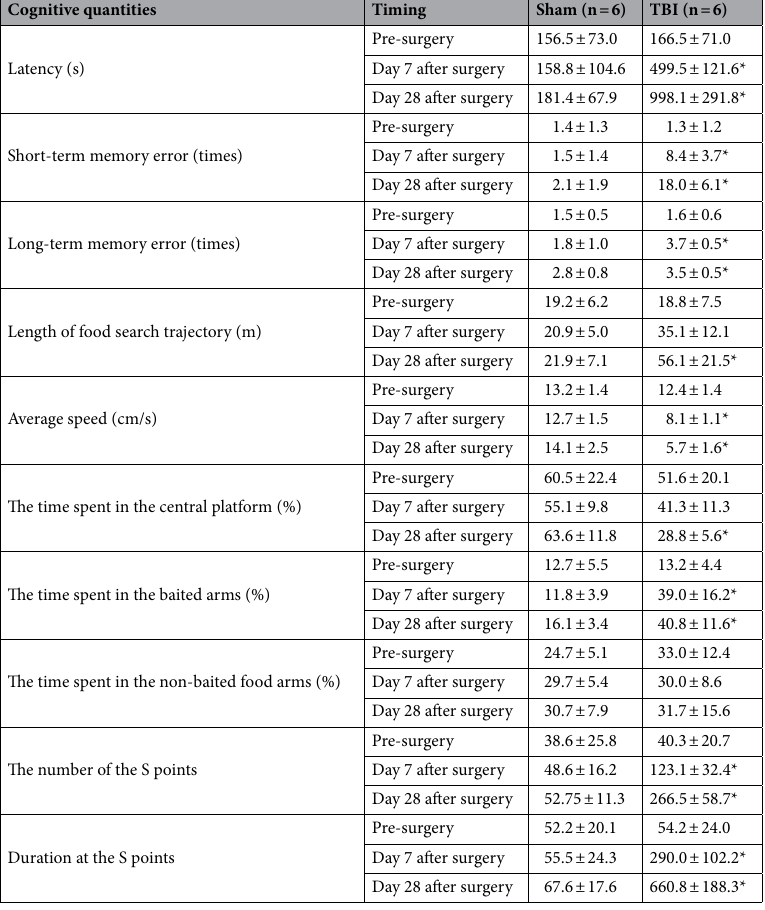
Table 1. Statistics on cognitive performance. Note that values are expressed as mean ± S.D. A student’s t-test was used to compare performance between both groups. * p < 0.05 indicated a statistical significance as compared with the sham group.